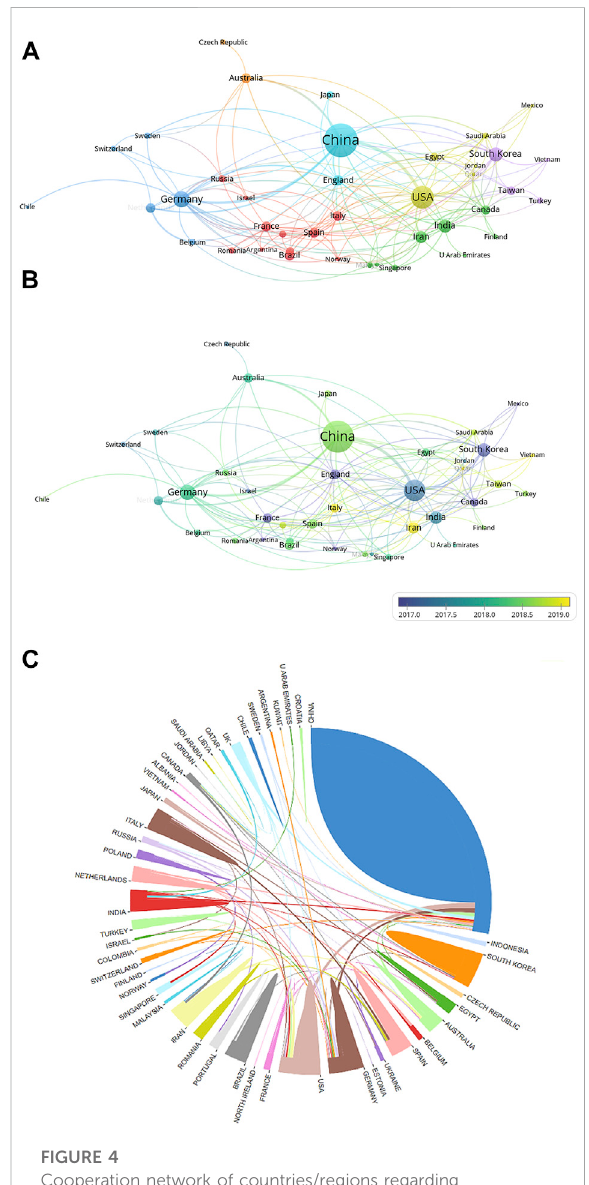
FIGURE 4 Cooperation network of countries/regions regarding research on metal materials and bone repair. (A,B) Network of cooperative relations between countries/regions established by VOSviewer (C) visualized cooperative relations between